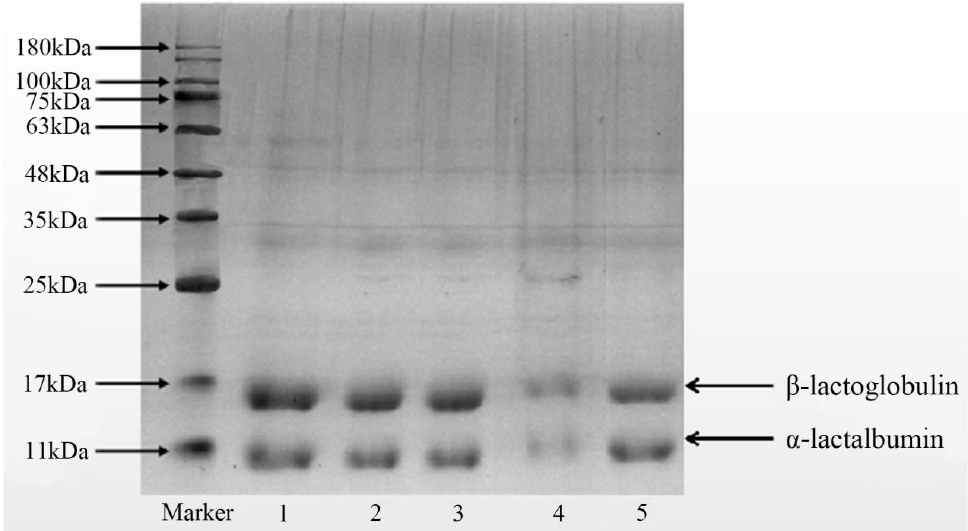
Figure A3. Sodium Dodecyl Sulphate–Polyacrylamide Gel Electrophoresis (SDS-PAGE) of the WP in the bovine milk heated at different temperature/time combinations (1: Raw milk; 2: 75 °C HTST; 3: 85 °C HTST; 4: IND-UHT; and 5: DSI-IUHT).